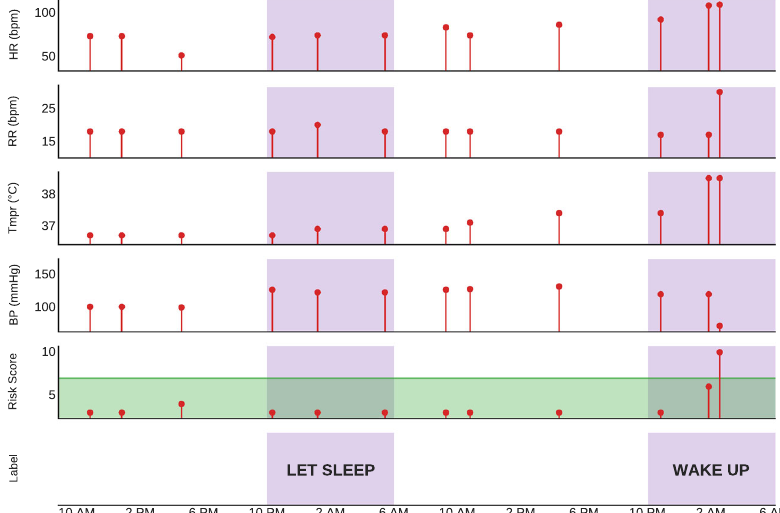
Fig. 1 Example of the input sequence and predicted overnight stability of a hospital visit. The model takes a sequence of features as input, with each sample containing four vital signs plus a risk score (included in the fi gure) and other input variables, including an hour of the day, time since the previous sample, change in risk score, and variance of risk subscores (not shown). The green band signi fi es the normal range of risk score values and indicates low risk for clinical deterioration. Nights (purple band) are labelled according to the model prediction at 10 p.m. each night ( “ Let Sleep ” or “ Wake Up ” ). In the example provided, on the fi rst night, the model predicted overnight stability and recommended that the patient sleep, whereas on the second night the model correctly predicted instability (i.e., elevated overnight risk score), thus recommending that the patient be woken for vital sign monitoring. Note that while in reality the model does not include measurements obtained during a predicted stable night, these are included in the fi gure for illustrative purposes. HR heart rate, RR respiratory rate, Tmpr temperature, BP systolic blood pressure, Risk score indicates Modi fi ed Early Warning Score (MEWS).